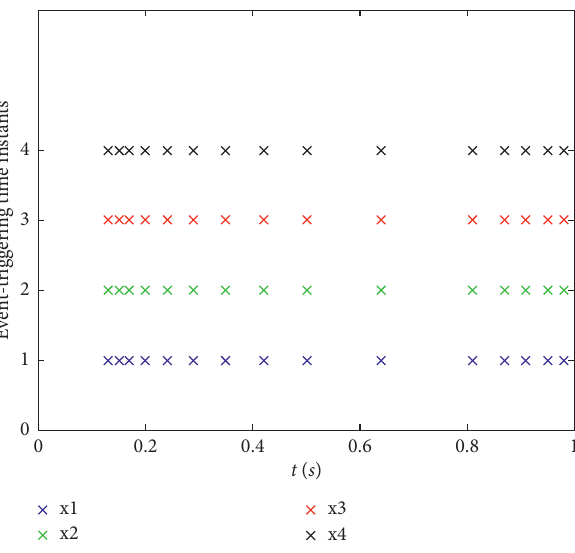
Figure 5: Event times instants for four agents in Theorem 1.